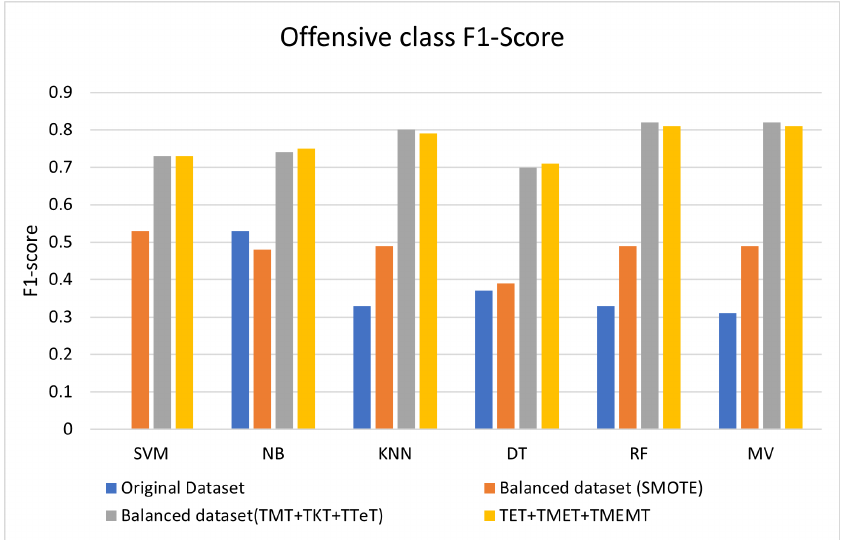
Figure 11. Offensive class F 1 -score for original dataset and balanced dataset.